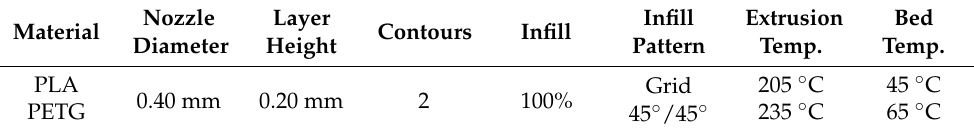
Table 1. 3D printing process